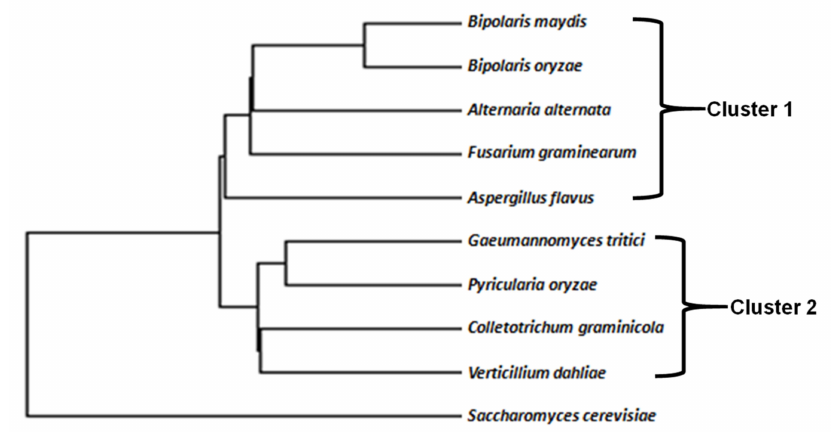
Figure 1. Cluster analysis of target fungal species based on zinc binuclear cluster coding sequences, nucleotide composition, and codon context parameters by ANACONDA